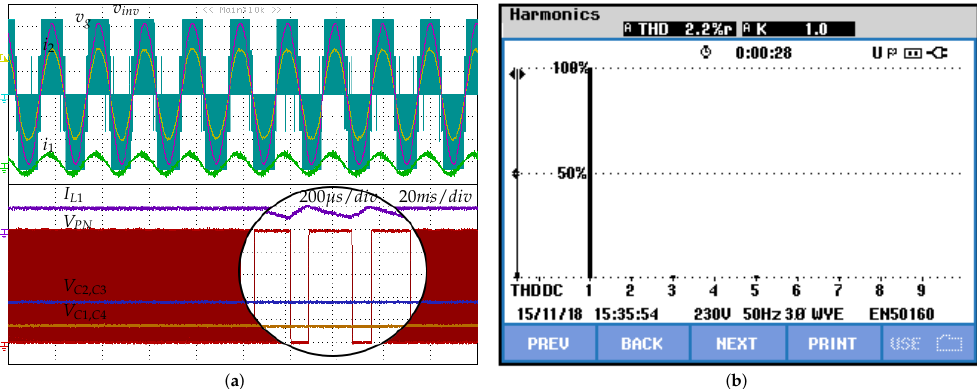
Figure 6. Experimental results of the steady-state analysis. ( a ) ac and dc side variables; ( b ) Harmonic spectrum of grid current. ( i 1 = 20 A/div, i 2 = 5 A/div, v g = 100 V/div, v inv = 150